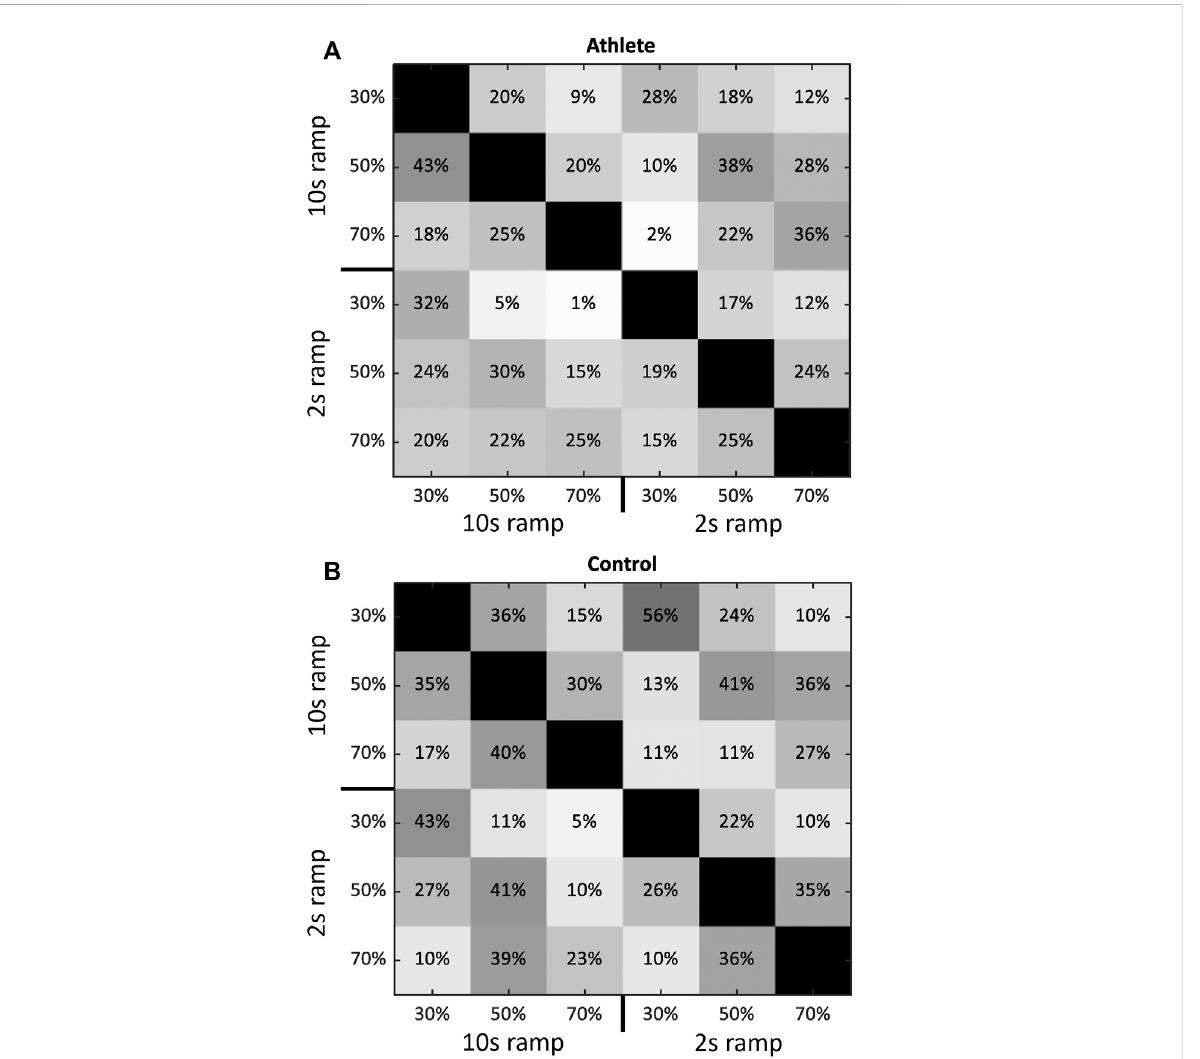
FIGURE 3 ThematchingresultsofMUactionpotentialsacrosstasks. (A,B) showstheresultsfromAthleteandControlgroup,respectively.Eachblockgivesthematched rate of MUs between the corresponding task in the vertical and horizontal axis averaged across subjects. The matching rates in the diagonal blocks are